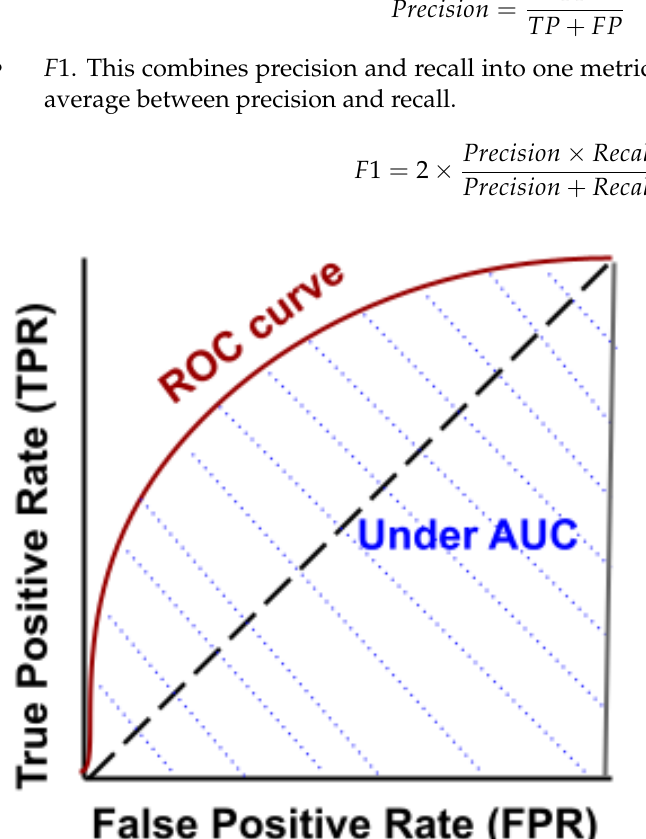
Figure 5. ROC and AUC plotting example.